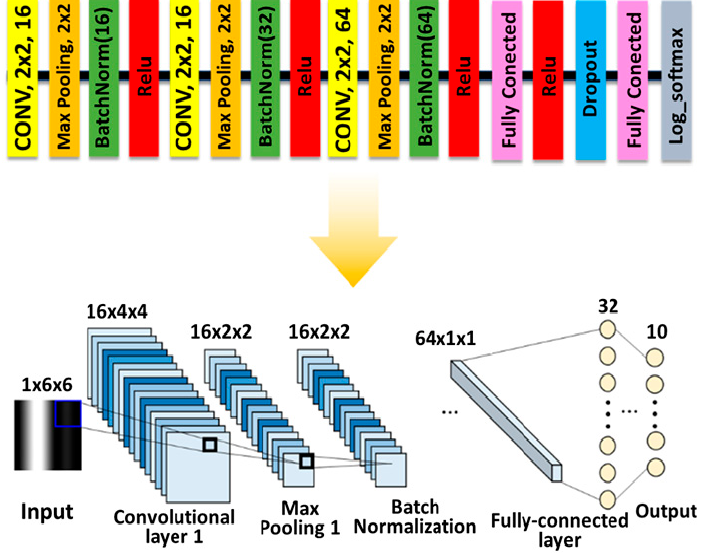
Figure 5. Architecture of the proposed convolutional neural network for hand postures classification.